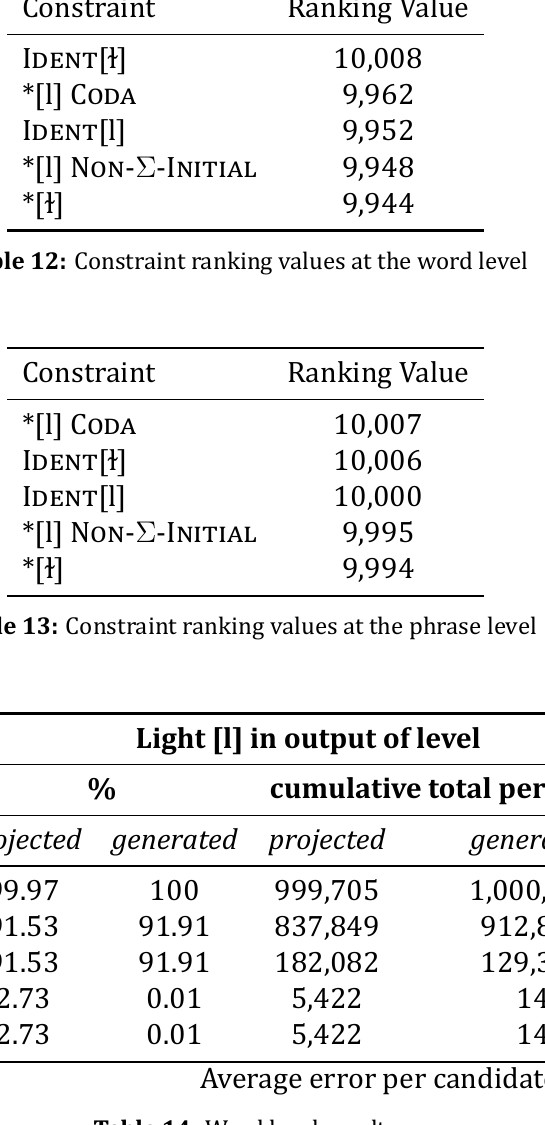
Table 14: Word level